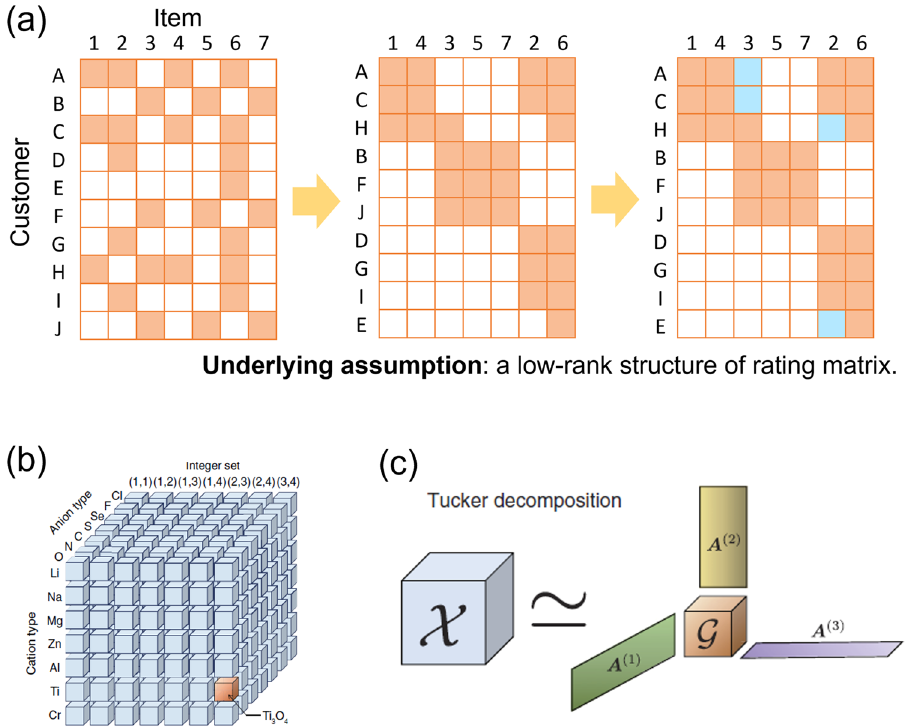
Fig. 4 Schematic illustration of matrix- and tensor-based recommender systems. a A simpli fi ed scheme of the matrix-based recommender system used in E-commerce. b An example of a 3rd order tensor expressing binary compounds. c Using the Tucker decomposition method, a large tensor can be approximated by a product of a small core tensor and three matrices. Adopted from ref. 14 with small modi fi